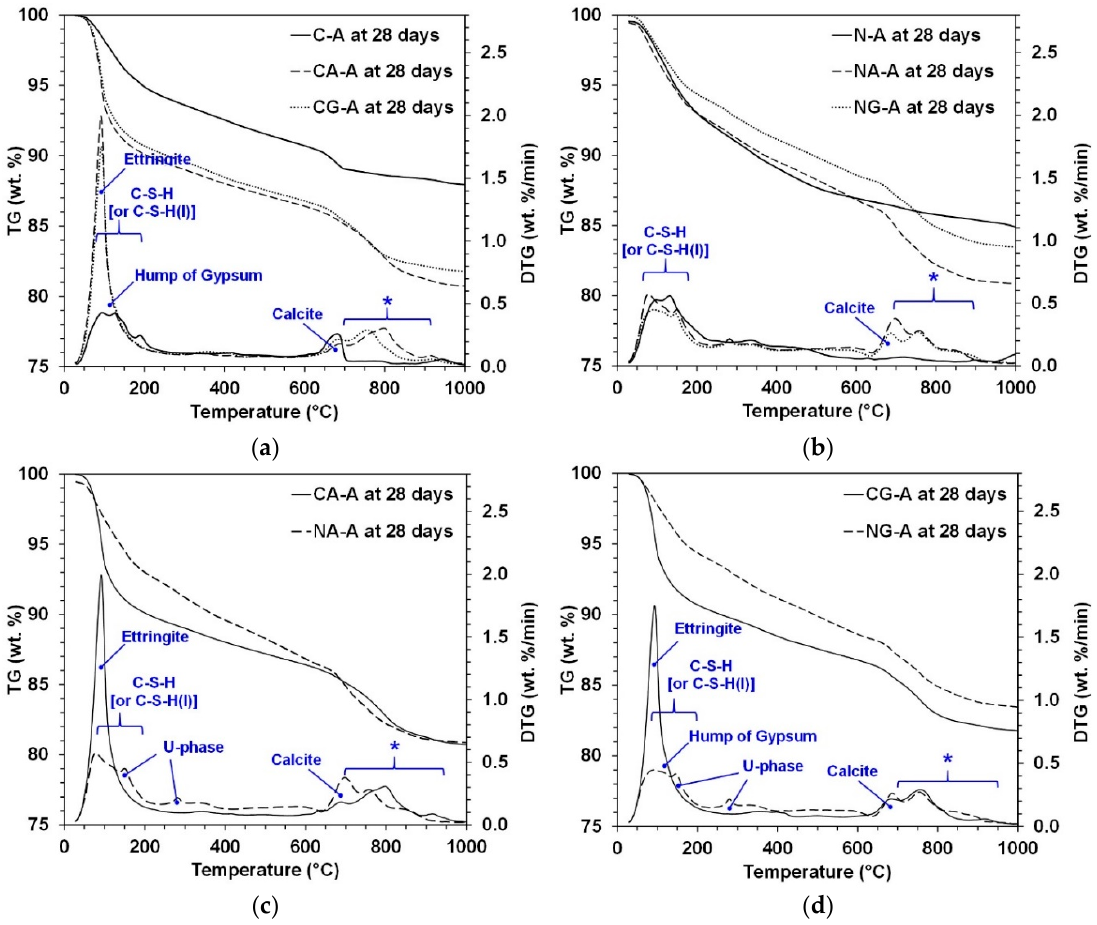
Figure 5. TGA and derivative thermogravimetry (DTG) results at 28 days; ( a ) effect of calcium sulfate type under CaO-activation, ( b ) effect of calcium sulfate type under NaOH-activation, ( c ) effect of activator type when anhydrite was present, and ( d ) effect of activator type when gypsum was present. *: Weight loss possibly related to glass of GGBFS.